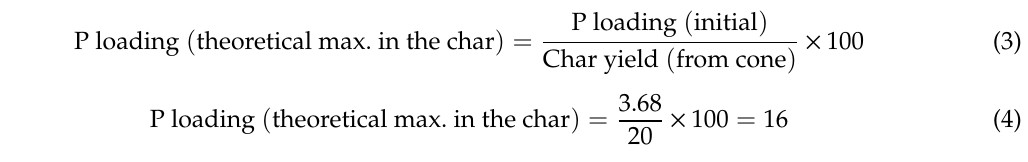
Table 1. Phosphorus contents, determined through inductively-coupled optical emission spectroscopy (ICP-OES) measurement, in the coating formulations and corresponding char residues.